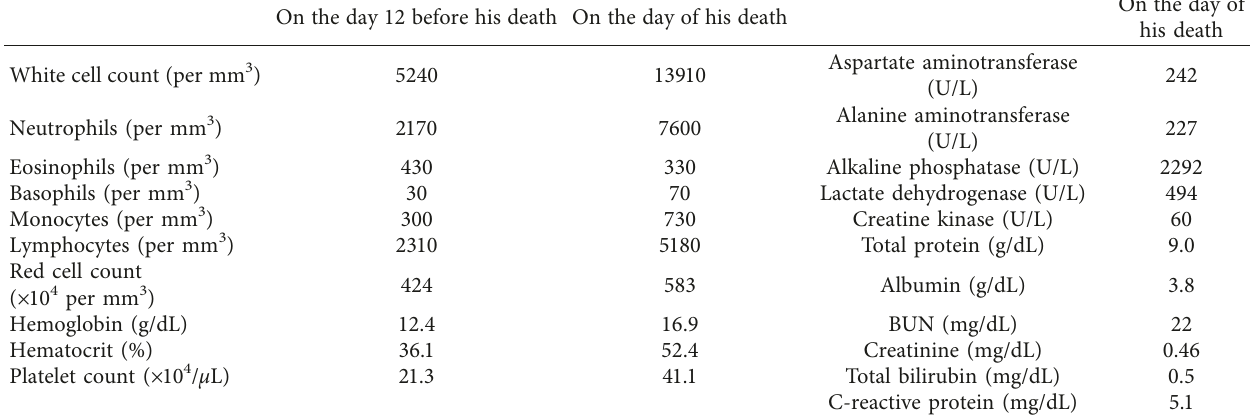
Table 1: Laboratory data of the